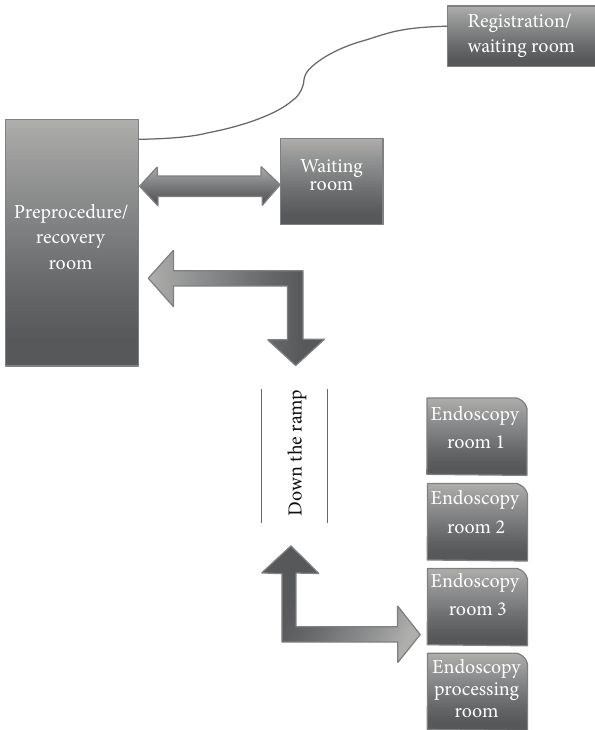
Figure 1: The Hotel-Dieu Hospital (Kingston, Ontario) endoscopy unit workflow. The patient arrives at the registration desk and, on registration, proceeds to the endoscopy suite wherein an endoscopy nurseadmitsthepatientdirectlyeithertothepreprocedure/recovery room or to the waiting room if a bed is unavailable. Once the preprocedure checklist is completed and the endoscopy room is available, the patient is transported down the ramp to one of the endoscopy